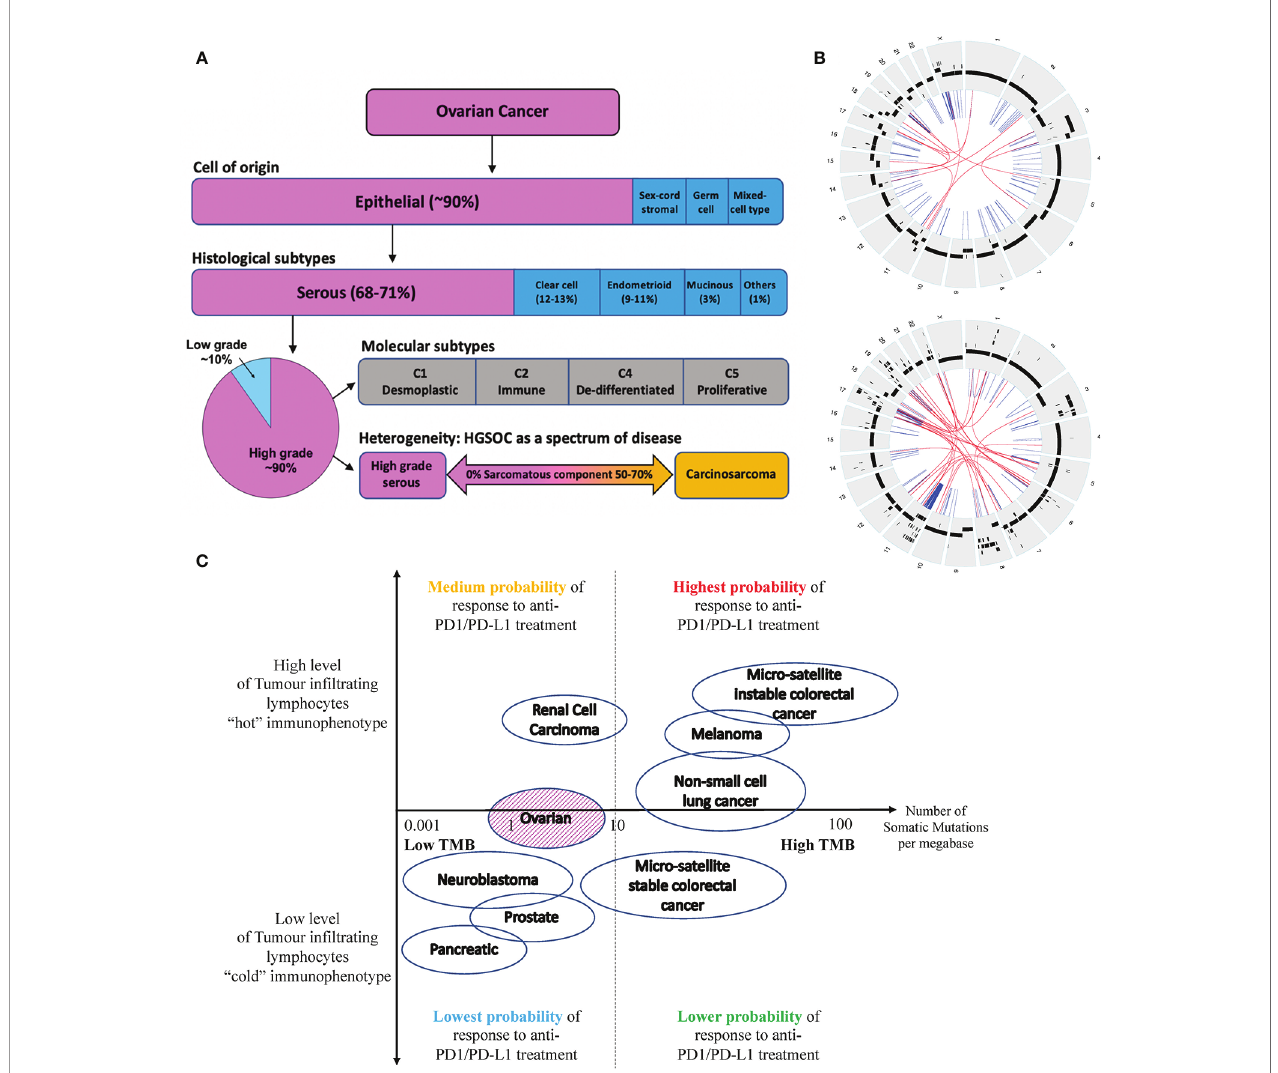
FIGURE 1 | (A) Ovarian cancer can be classi fi ed into four subtypes based on their cell of origin and histological characteristics. Epithelial OC is the most common subtype of OC, which can be further divided into 5 histological groups. HGSOC is the most common subtype of EOC accounting for about 70% of cases and is associated with the poorest prognosis. HGSOC can be further molecularly sub-classi fi ed based on its gene expression pro fi le, into 4 groups (C1, C2, C4 and C5). Ovarian or fallopian tube derived carcinosarcoma (O/FTCS) is a rare subtype of OC and may belong within the spectrum of HGSOC tumor. (B) CIRCOS plots of a patient with HGSOC (top) and a patient with OCS (bottom) with low tumor mutation burden – demonstrating a high degree of chromosomal instability (C) Schematic diagram of tumors with high and low tumor mutation burdens versus in fl amed and non-in fl amed immunophenotypes based on their T-cell and IFN signature. Although some ovarian cancers may have low TMB, these tumors may still respond to ICI if they are associated with a “ hot ” immunophenotype. Completely “ cold ” tumors are those associated with low TMB and cold immunophenotype features, such as pancreatic, prostate cancer and some